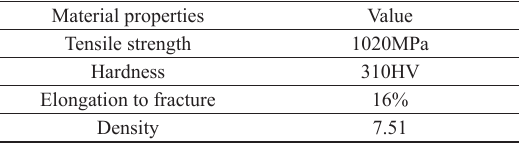
Table 1. Material properties of Nitinol